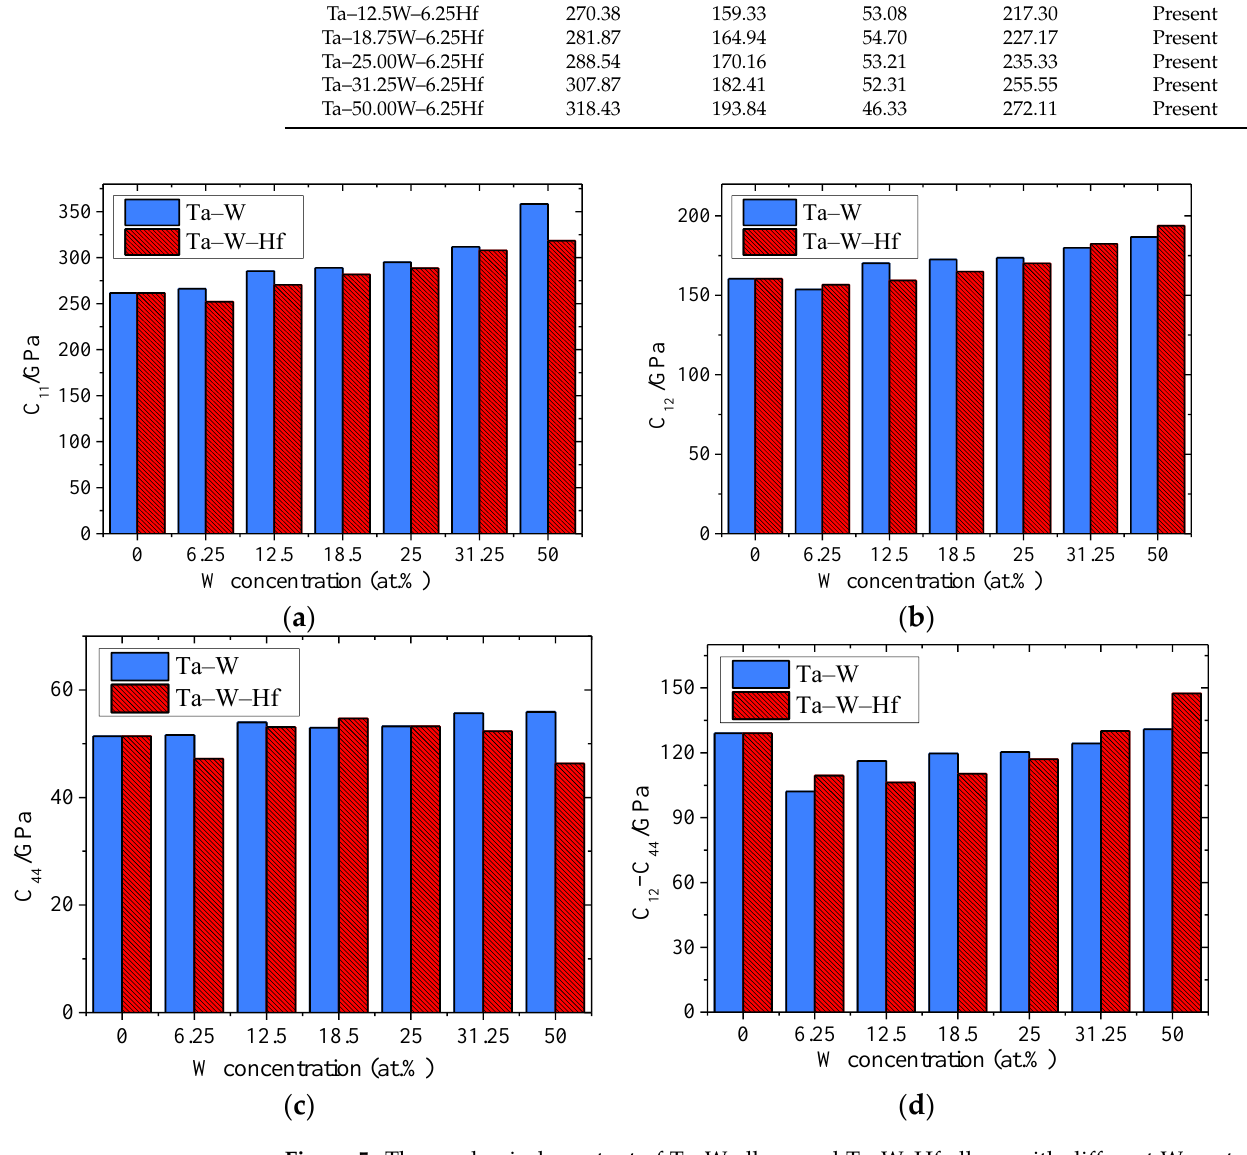
Figure 5. The mechanical constant of Ta–W alloys and Ta–W–Hf alloys with different W content. ( a ) C 11 , ( b ) C 12 , ( c ) C 44 , ( d ) C 12 –C 44 . The shear modulus and Young’s modulus of the Ta–W–Hf alloy show a trend of increasing and then decreasing with the increase in W content. When W concentration is less than 31.25%, the shear modulus and Young’s modulus of the Ta-W–Hf alloy increase with the increasing W content. When the W content reaches 31.25%, the shear modulus and Young’s modulus of the Ta–W–Hf alloy increase by 51.9% (G) and 42% (E), respectively, compared to pure Ta. When the W content over 31.25%, the shear modulus of Ta–W–Hf decreases from 56.26 GPa of Ta–31.25W–6.25Hf to 52.17 GPa of Ta–50W– 6.25Hf, a decrease of 7.3%. The trend of Young’s modulus is similar to that of shear modulus: the Young’s modulus decreases from 155.75 GPa (W = 31.25%) to 145.73 GPa (W = 50%) with a decrease of 6.4%. The rate of decrease in Young’s modulus is lower than that of shear modulus, however the shear modulus and Young’s modulus of the Ta–W–Hf alloy are still higher than that of the pure Ta. Table 4. The calculated elastic constants of Ta–W alloys and Ta–W–Hf alloys with different W content (unit: GPa). Alloy